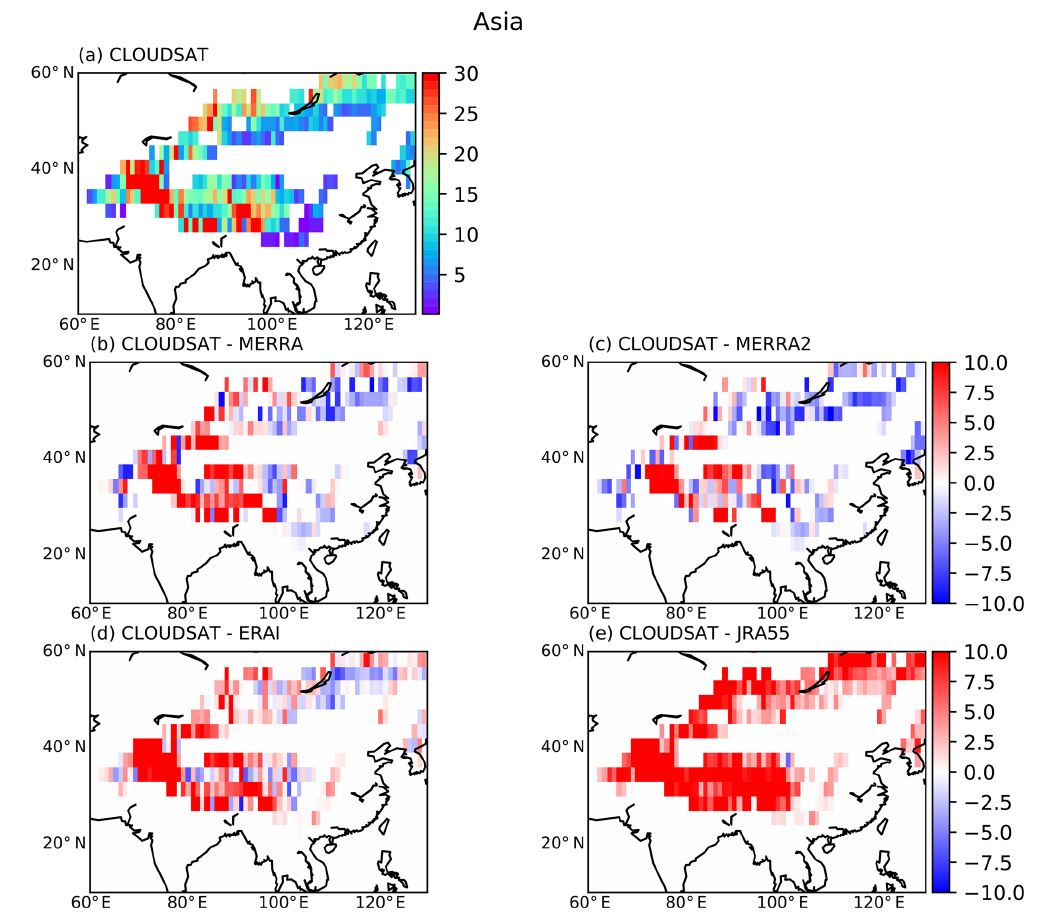
Figure 3. Spatial maps of the global cumulative mountain snowfall (millimeters per month per grid box) over high-mountain Asia for (a) CloudSat, (b) CloudSat minus MERRA, (c) CloudSat minus MERRA-2, (d) CloudSat minus ERA-Interim and (e) CloudSat minus JRA-55 over the time period